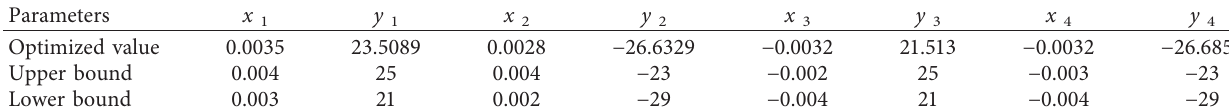
Table 9: Parameters optimized by the GA.